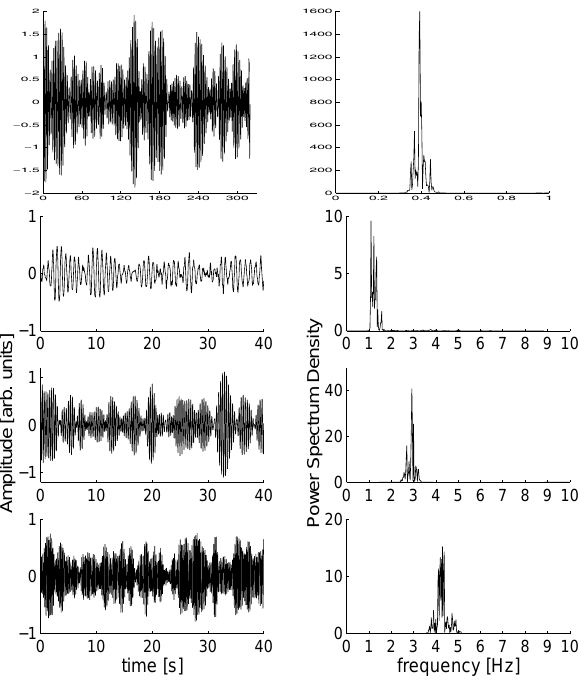
Fig. 4. ICA decomposition of Strombolian tremor: four independent signals are extracted with spectral content in the following ranges: [0.1–0.5], [0.8–1.5],[2–3.5], and [4–6]Hz (from De Lauro et al. 2005a, 2008).